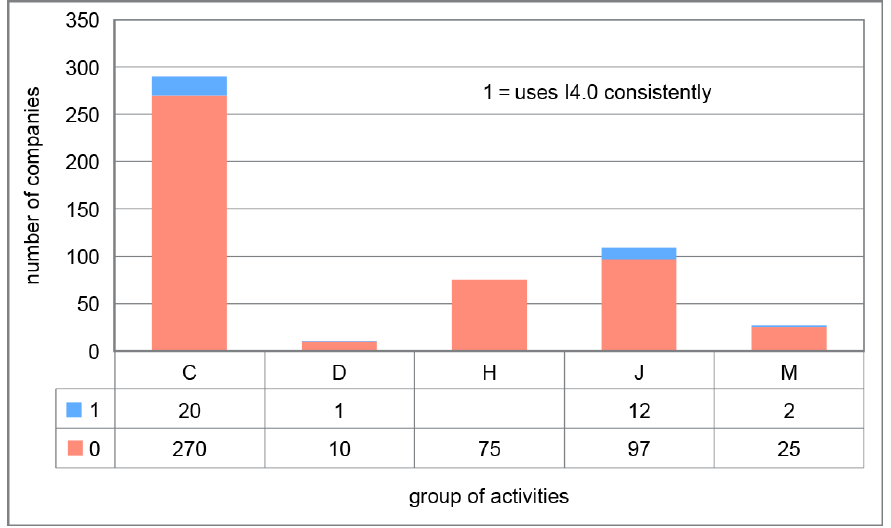
Figure 1. Distribution of the training sample.